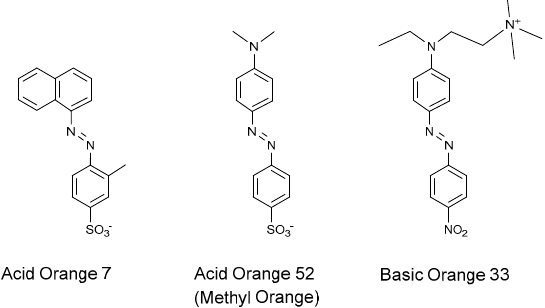
Figure 6. Three azo dyes (Acid Orange 7, Acid Orange 52, and Basic Orange 33) were used as the substrates in the first study about bleaching by Mn(III) porphyrins.